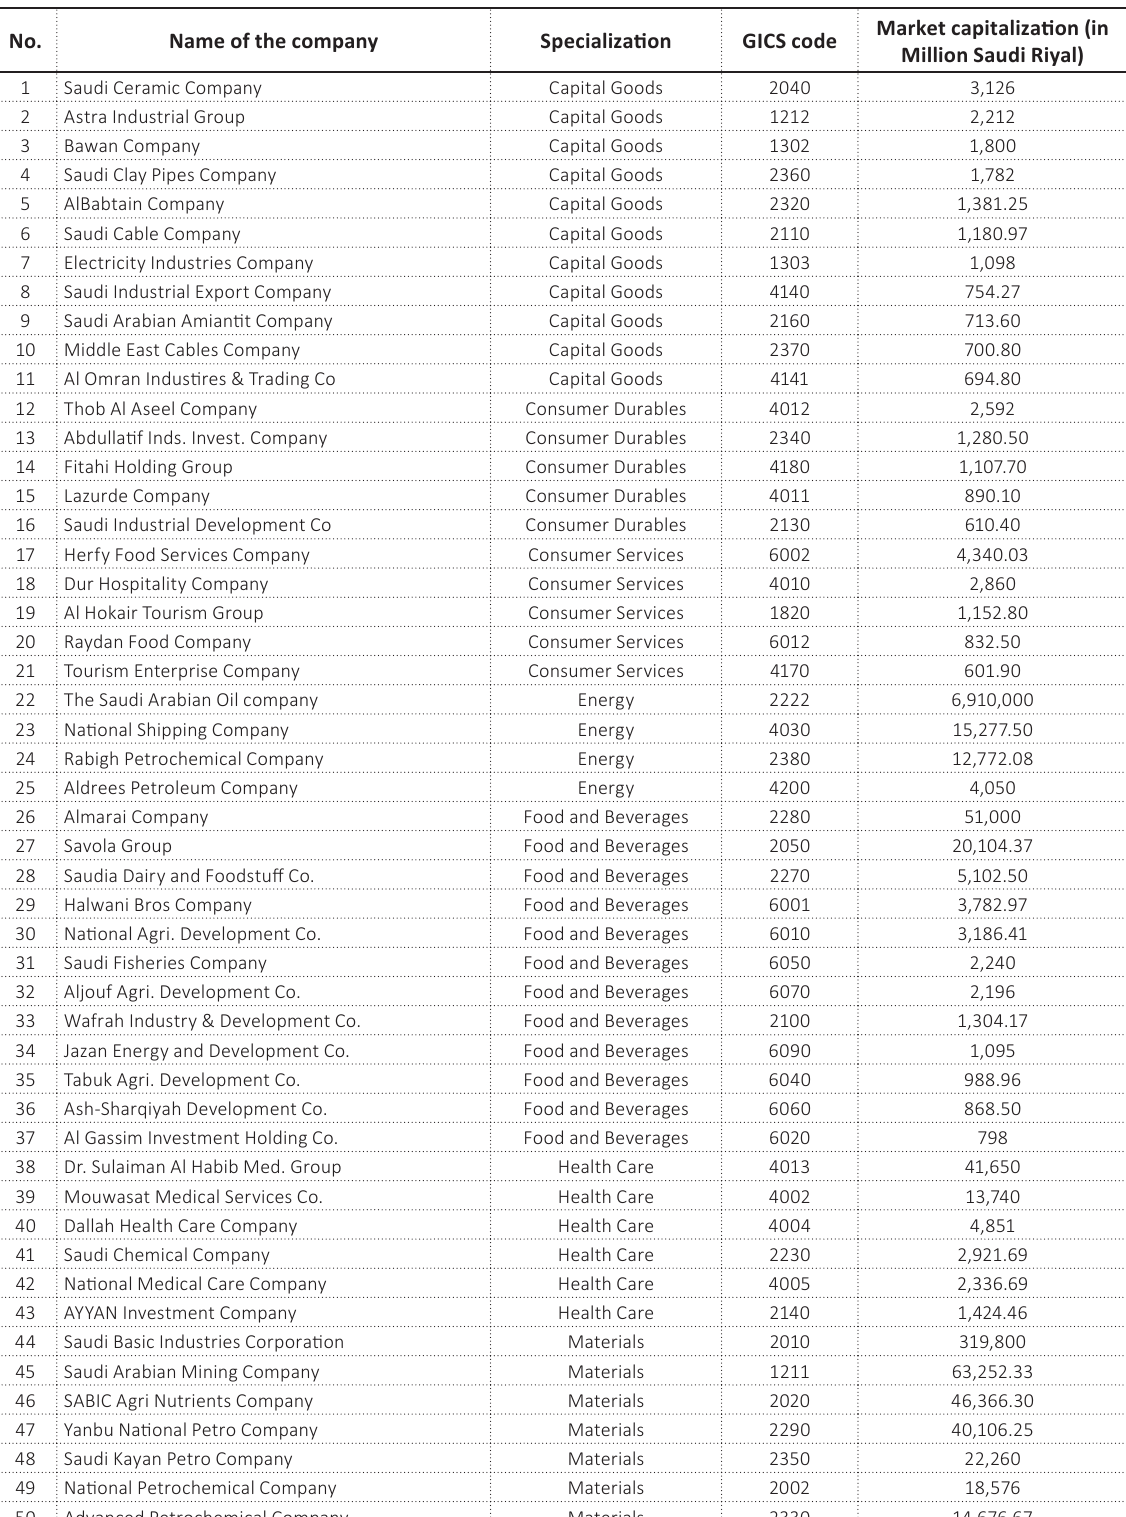
Source: The Tadawul Stock